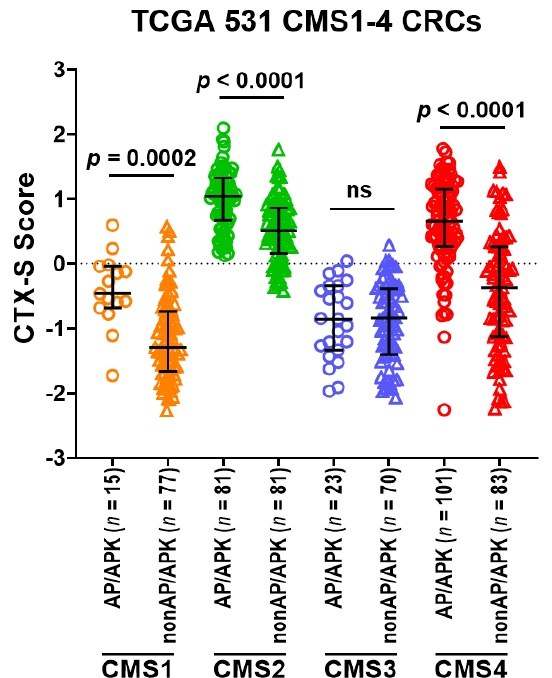
Figure 5. ( A ) Comparison of CTX ‐ S scores among four CMS classes in TGCA CRC tumors. Bars represent median with interquartile range. p values are for two ‐ tailed Welch t test. ( B ) Frequencies of six subgroups of MUT APC (A)/MUT TP53 (P)/MUT KRAS (K) across CMS1 ‐ 4 classes.